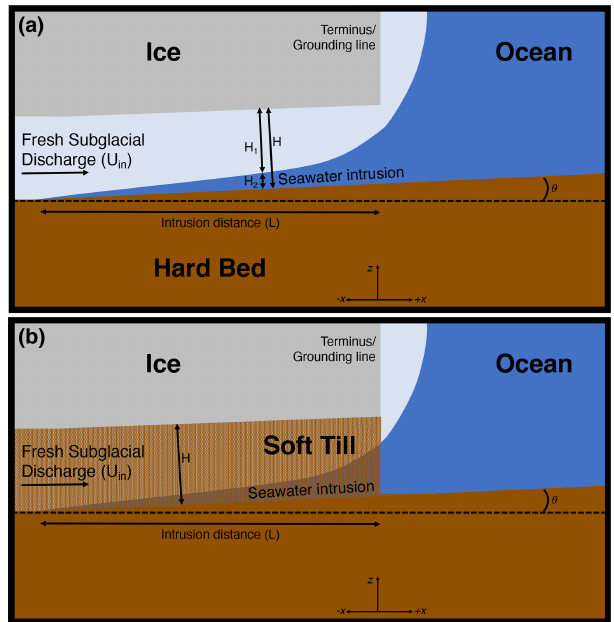
Figure 1. Illustration of seawater intruding under grounded ice with relevant variables labeled. (a) Hard-bed case. (b) Confined soft-bed case. Relative vertical scale exaggerated for